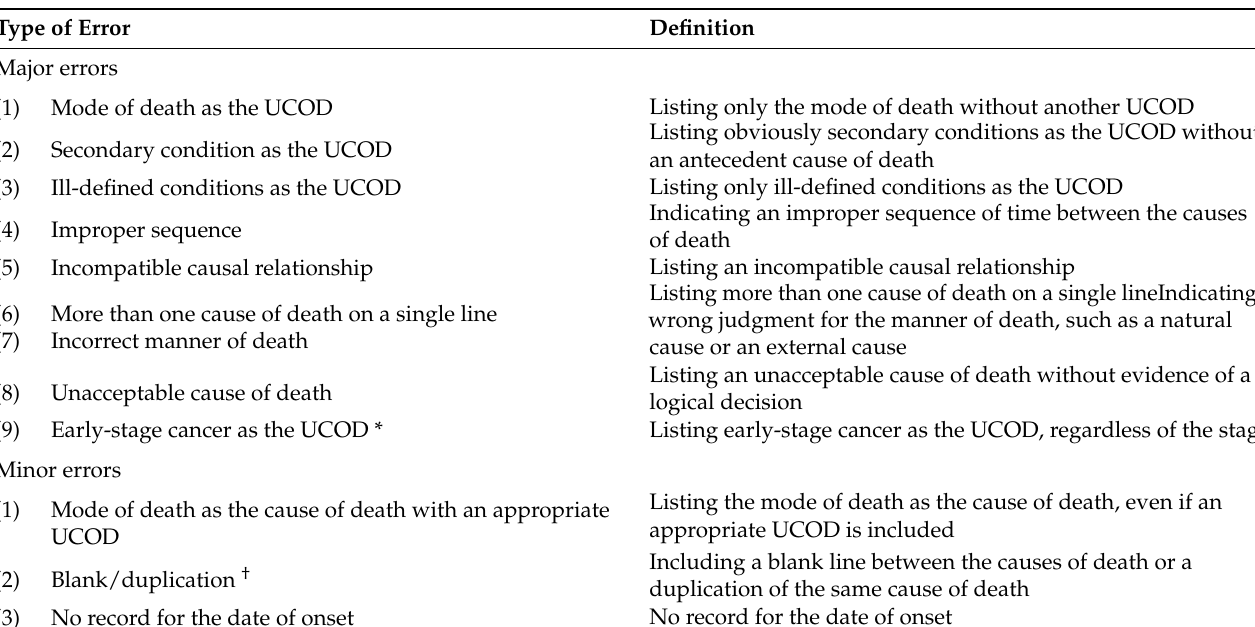
Table 1. Definitions of major and minor errors on death